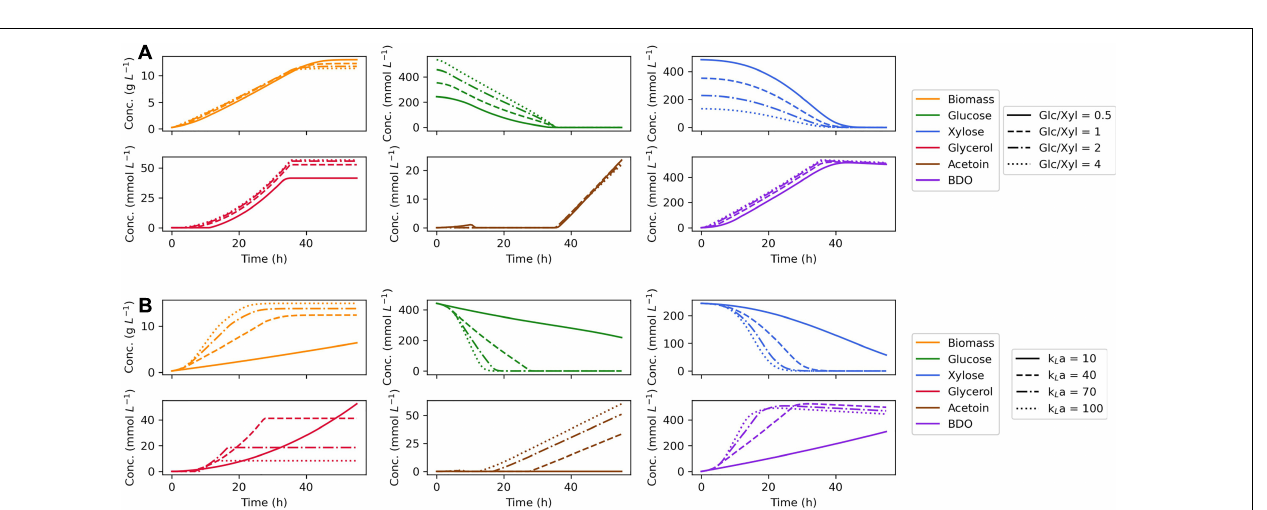
FIGURE 4 | Comparison of dynamic flux balance model predictions (lines) and experimental data (dots) for Z. mobilis BC42C (cid:49) pdc co-utilizing glucose and xylose. The estimated kinetic parameters are used in substrate uptake kinetics. The lower bound of non-growth associated maintenance (NGAM) is set to zero. Reuptake of products acetoin and BDO are allowed for a better match of the experimental results.